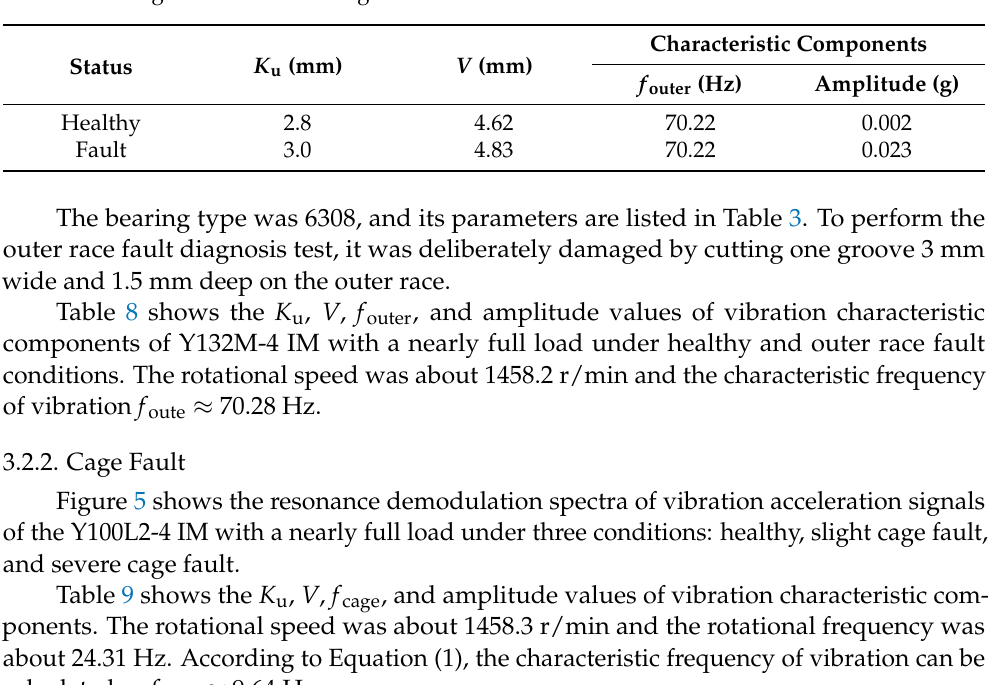
Table 7. Bearing outer race fault diagnosis results of the Y100L2-4 motor with a half load. Status